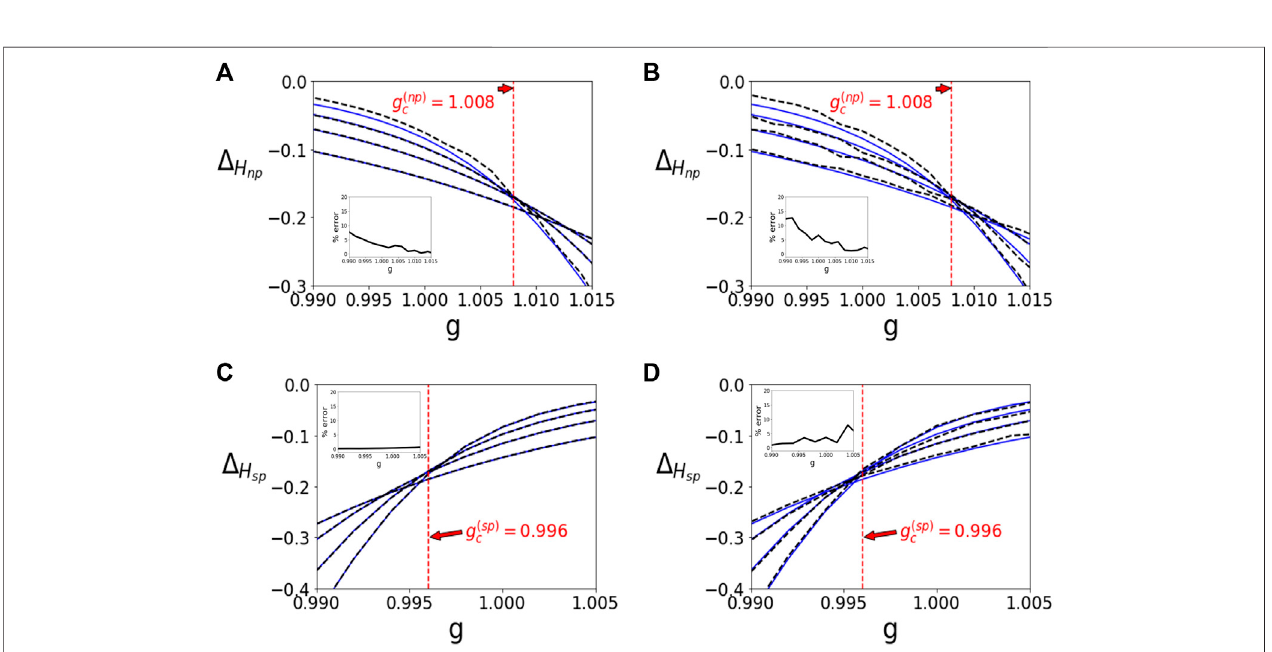
FIGURE4| Finite-SizeScalingforQuantumRabimodel . Weused N =8,10, ... ,32. (A) Graphsof Δ H ( g ( N ) ; N − 4 , N − 2 ) (cid:1) Δ of g . (B) Intersection points g ( N ) np where Δ H np np ( g ; 8 , 10 ) , Δ ( g ; 10 , 12 ) , ... , Δ ( g ; 30 , 32 ) as a function of g . (D) Intersection points g ( N ) Graphs of Δ H H sp H sp sp function of 1/ N . As N → ∞ , g ( N )